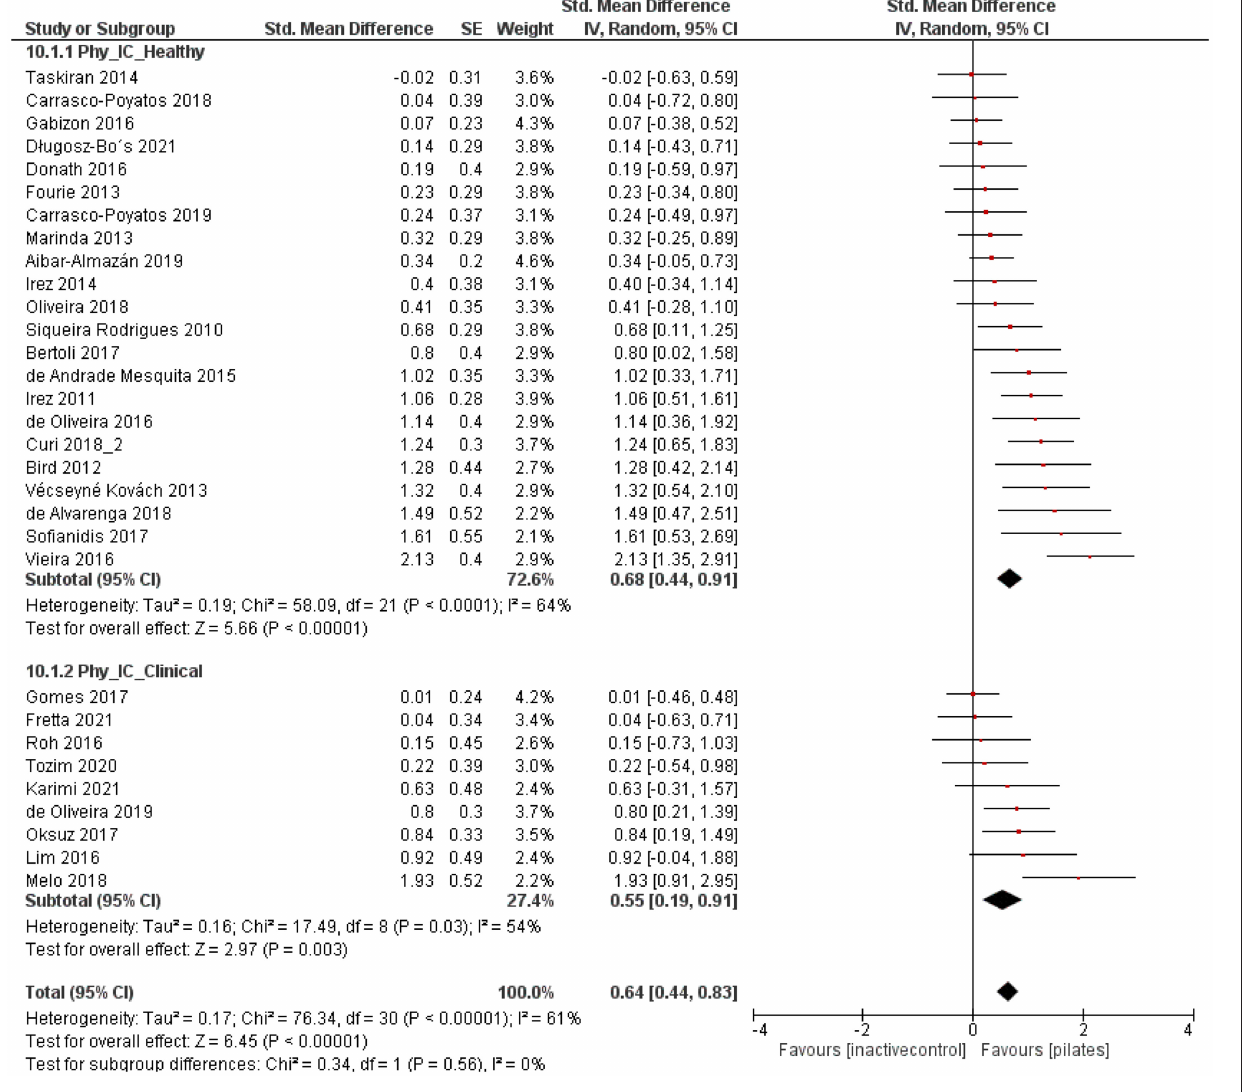
FIGURE 4 | Forest plot of standardized mean effects of Pilates intervention on physiological health parameters compared to inactive control groups. Data are presented for healthy older adults and older adults with clinical conditions. SE, standard error; IV, inverse variance model; CI, confidence interval; Std.,